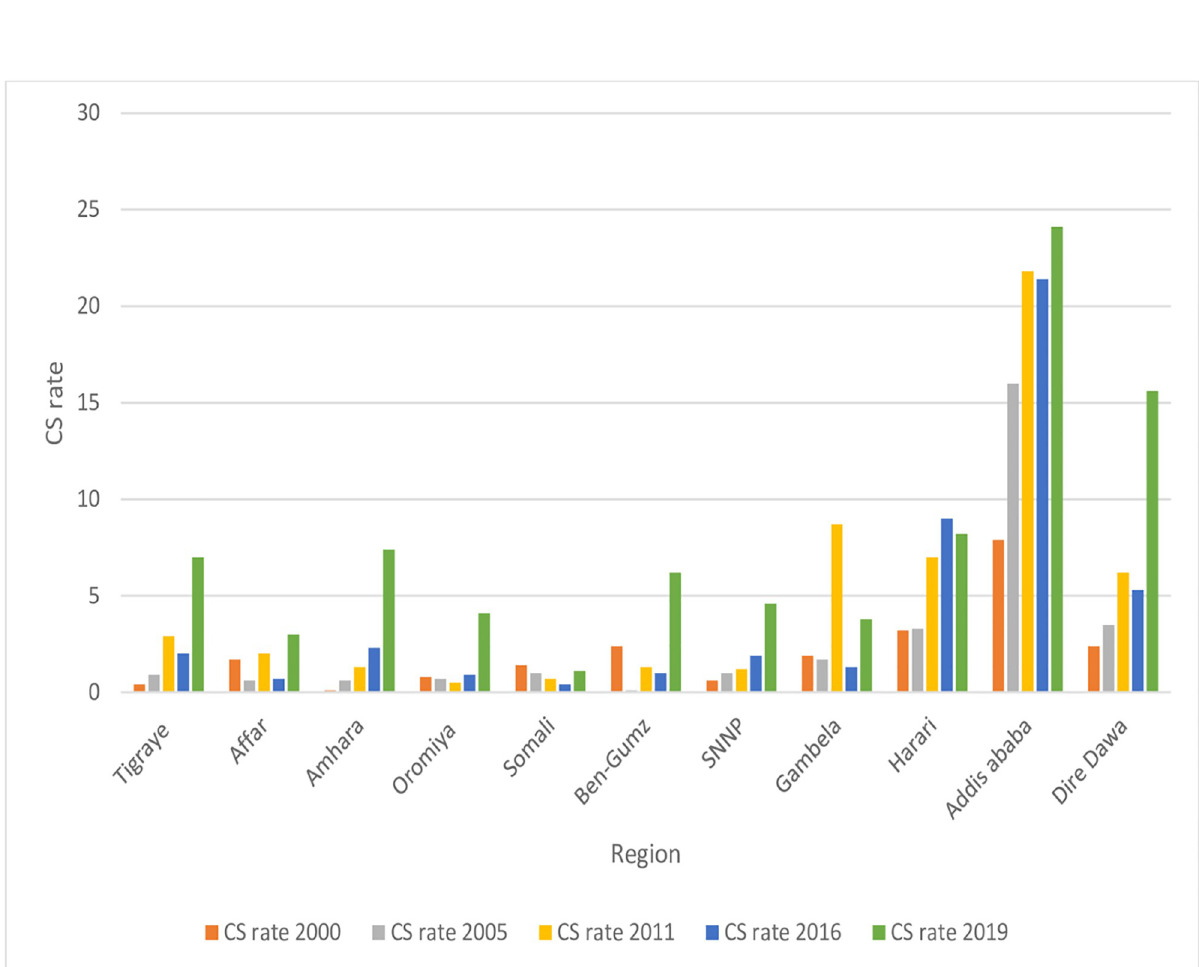
Fig 2. The trend of CS rate across the administrative region from (2000–20019) survey year.